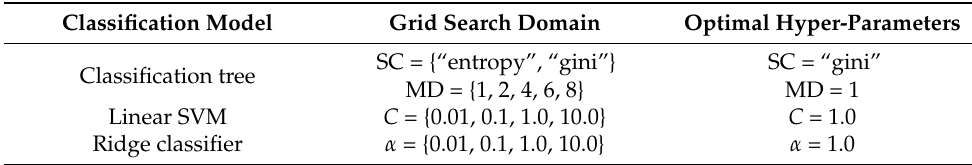
Table 2. Hyper-parameter tuning. Key to symbols: SC = splitting criterion; MD = maximum depth of the classification tree; C = regularization parameter; α = regularization strength.